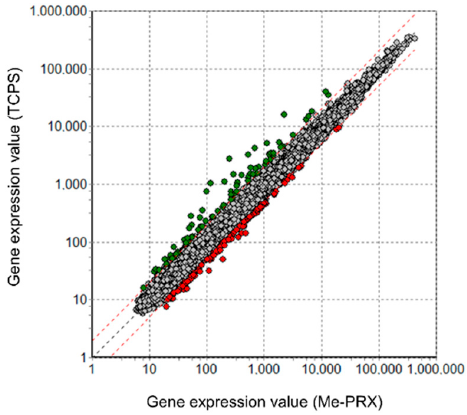
Figure 4. Growth curves of BALB / 3T3, MC3T3-E1, and MC3T3-G2 / PA6 cells on the surface of Me-PRX (closed circles) and TCPS (open circles) during a 5-day cultivation period. The initial cell seeding density was 2.0 × 10 3 cells / cm 2 . Data are presented as mean ± standard deviation (S.D.), n = 4. * p < 0.05 (Student’s t -test).